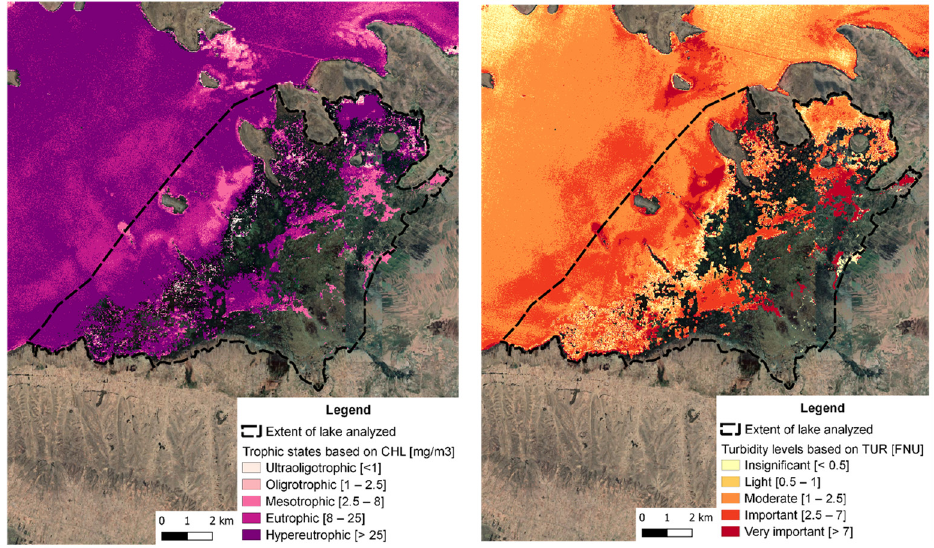
Figure 6. Distribution of CHL and TUR concentrations.